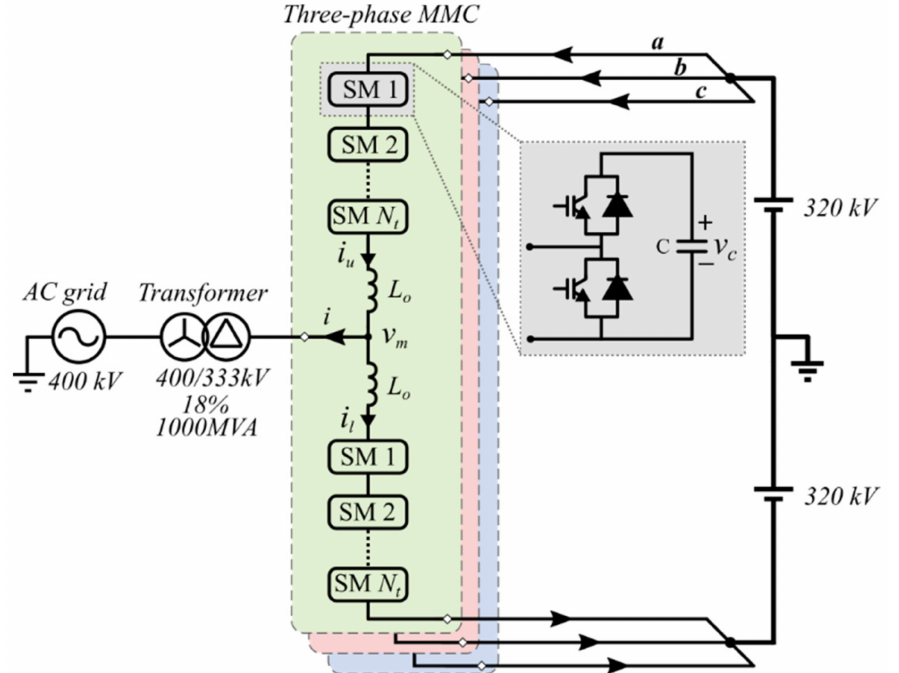
Figure 12. Simulated three-phase MMC system in RTDS.